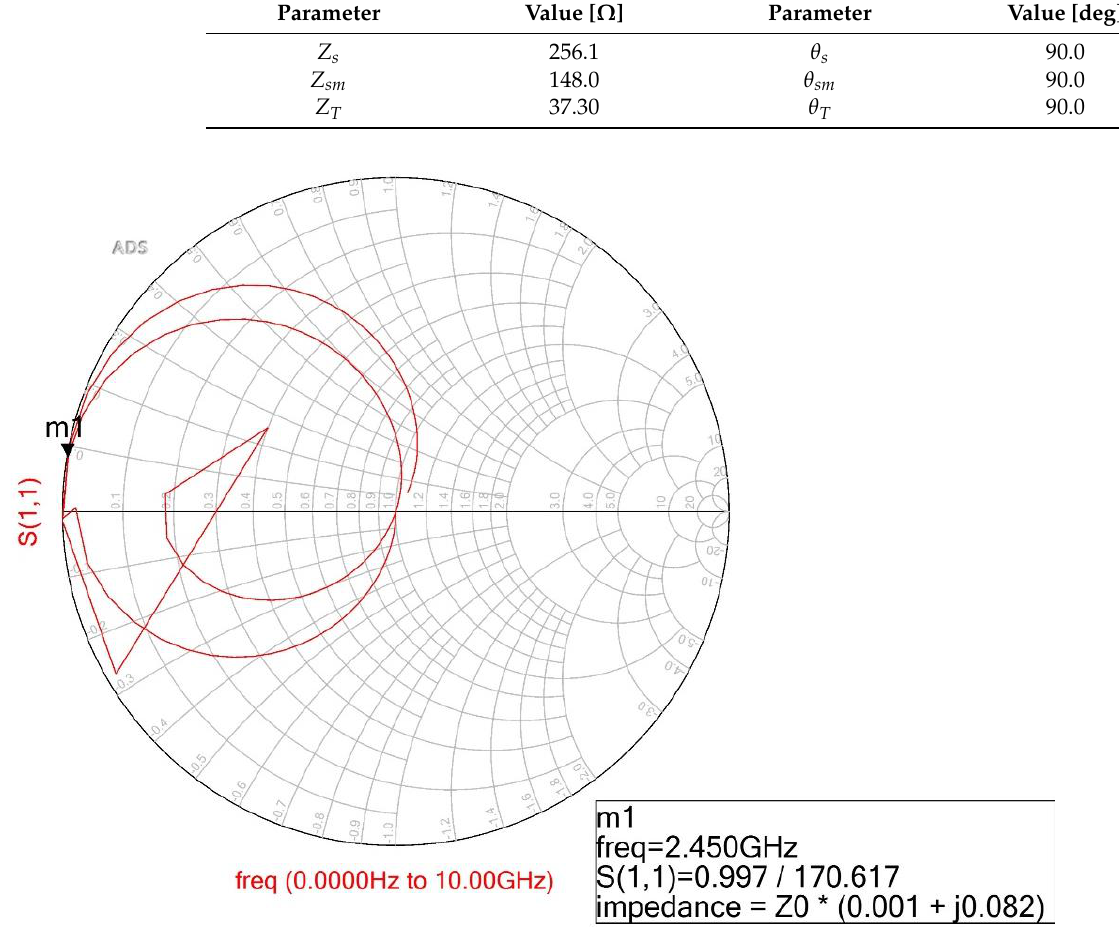
Figure 2. Simulation result for real and imaginary impedances for a conventional BPF.